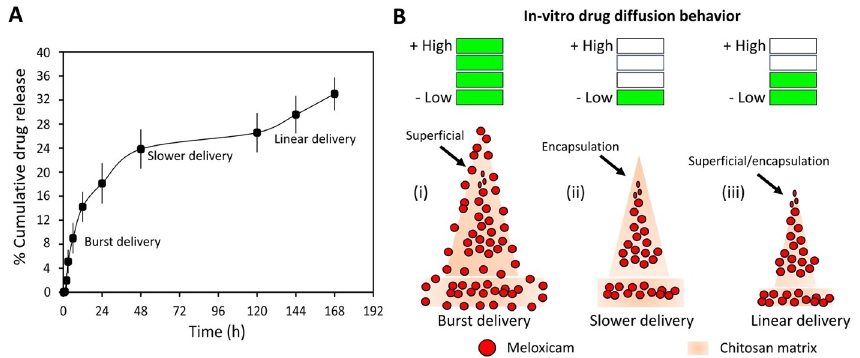
Fig 6. In-vitro drug release analysis reports that microneedles provided a sustained release with approximately 33.02 ± 3.88% of the meloxicam released for 7 days. A) In-vitro % cumulative drug release profile of meloxicam from microneedle patches, B) Schematic representation of drug release (i) Brust delivery, drug on microneedle patch surface, (ii) Slower delivery, drug encapsulated, (iii), linear delivery, drug on microneedle patch surface and encapsulated. Data are presented as the mean ± standard deviation of n = 3